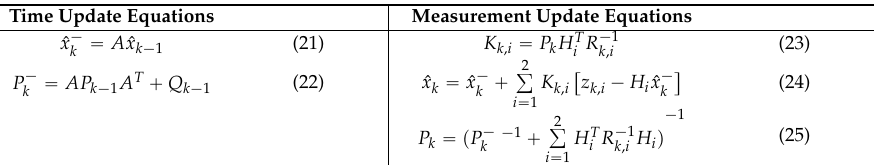
Table 3. Kalman Filter Equations for Centralized